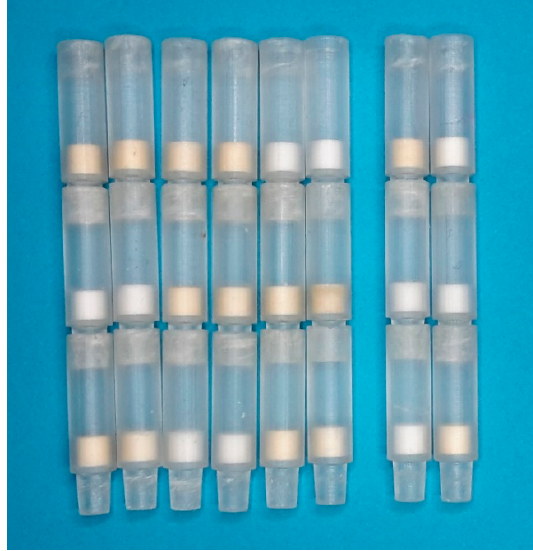
Figure 6. Picture of the stacked multi-filter columns. They are ordered in the same way as their measurement signals are shown in Figure 7. The left six columns (Column 1–6 in Figure 7) contain all possible combinations of 3 different coated filters, each flushed with both target antigens. The two columns on the right (A and B in Figure 7) are the ones where just one analyte was flushed over, they are stacked in the same order as column 1. All the filters are 5 mm high, and the outer diameters of the filter holder are 7.5 mm.